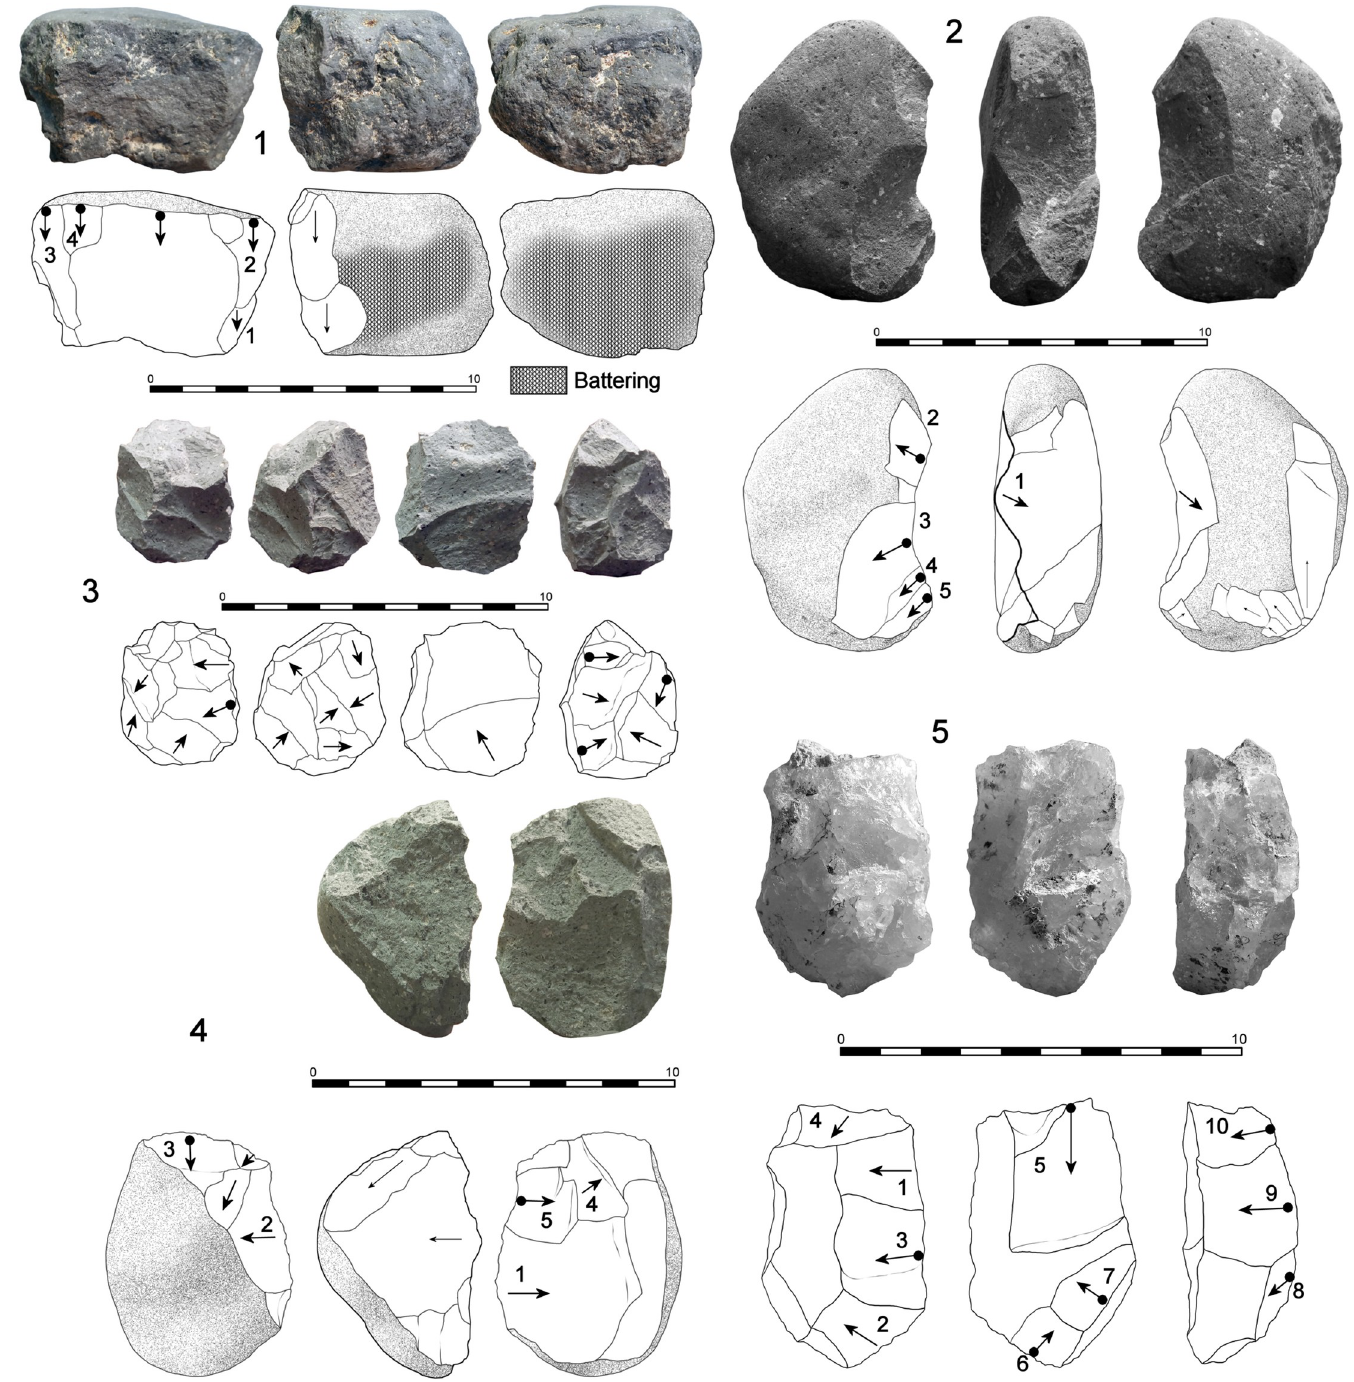
Fig 4. Cores from DS. 1. Unifacial linear (UL) core on basalt with intense battering due to percussion (67x59x48 mm, 322 g); 2. Bifacial linear (BL) core on phonolite, showing proximal scarring due to percussion (86x53x32 mm, 247 g); 3. Phonolite multifacial multipolar (MM) core in a final stage of exploitation (46x38x32 mm, 71g). Negative scars with step termination are abundant; 4. Bifacial alternating core (BA) on phonolite, following an alternating reduction pattern on both surfaces (67x53x42 mm, 180 g); 5. Bifacial orthogonal (BO) core on a quartzite fragment. In fact, the specimen shows series on three different planes, one of which presents a clear orthogonal pattern (65x42x29 mm, 103